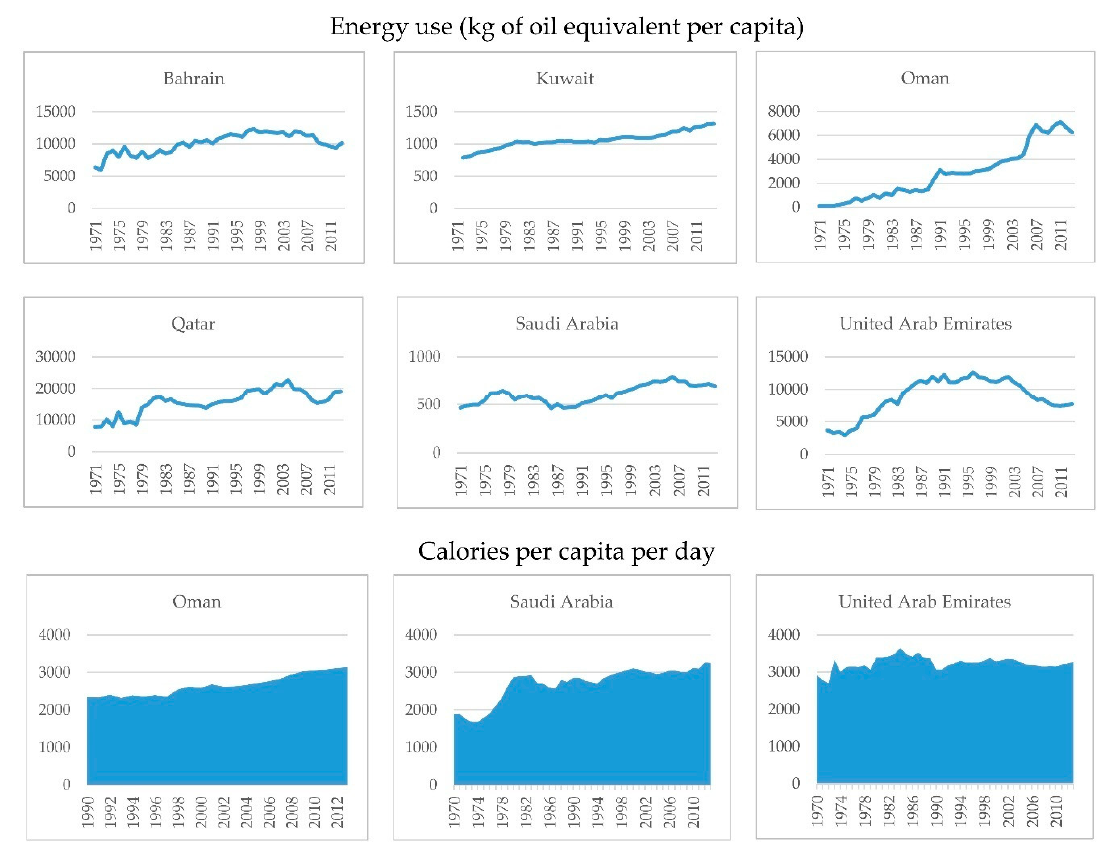
Figure 2. Demographic and resource-use growth in the GCC countries (based on data from the World Bank, FAO & FAO AQUASTAT).